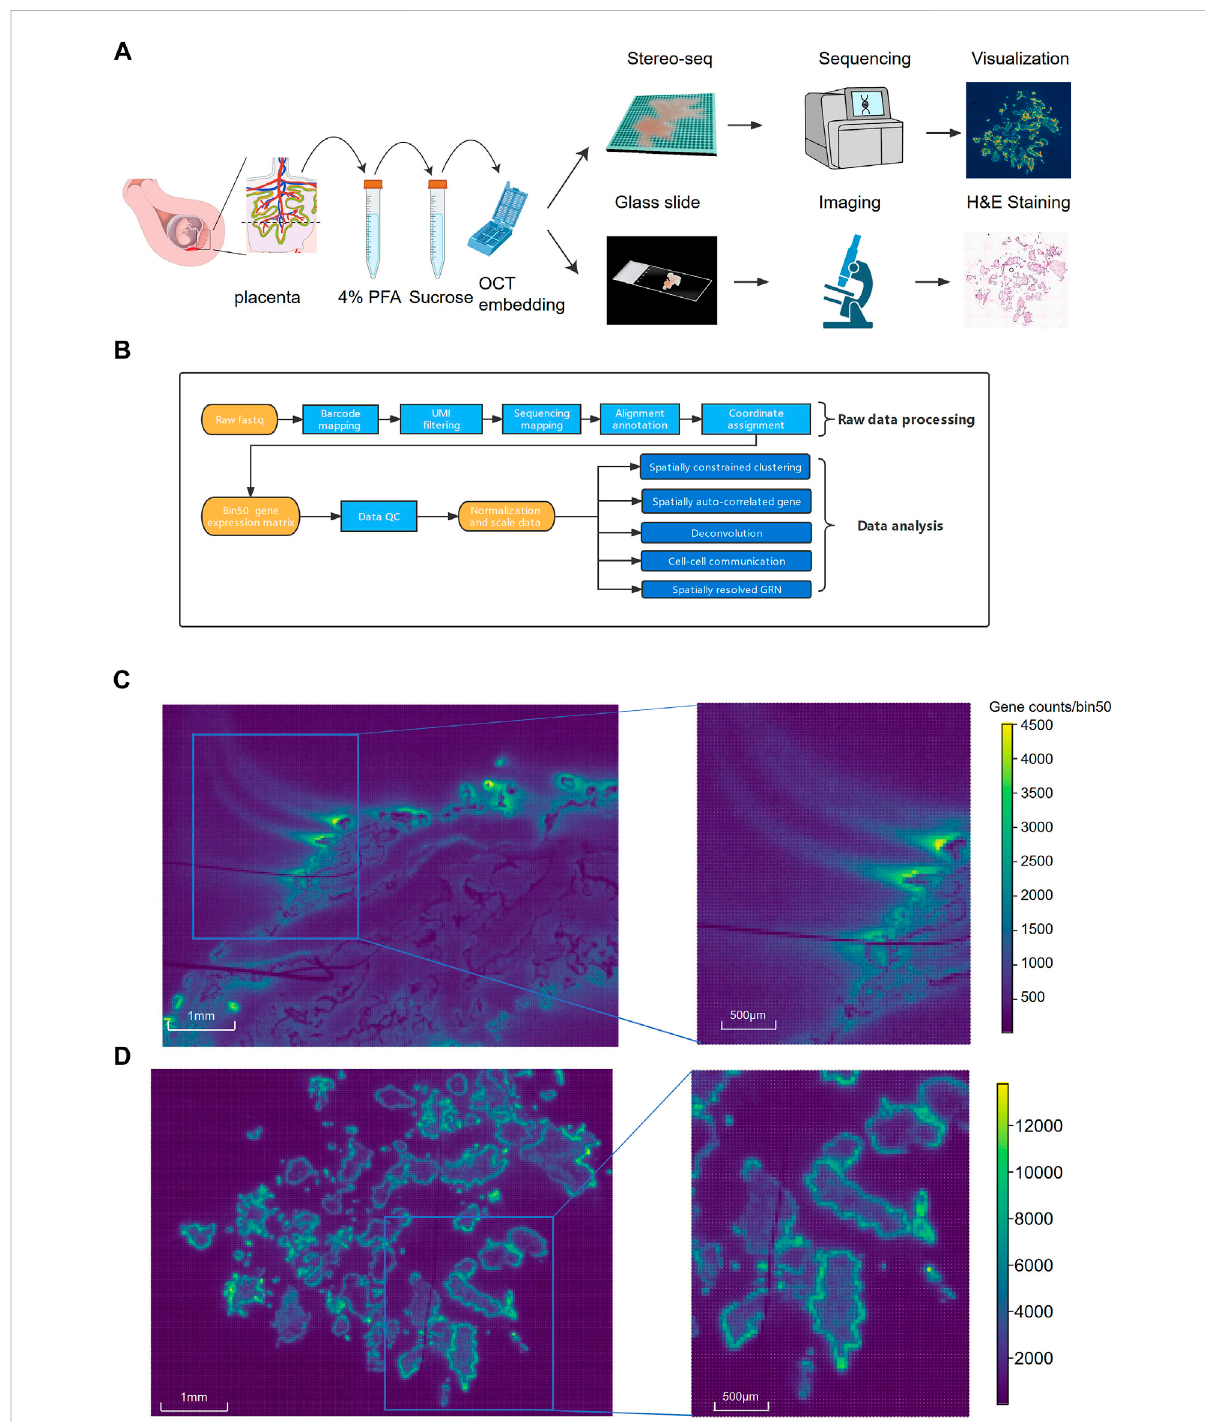
FIGURE 1 The schematic diagram of the experimental, data analysis work fl ow and comparison of Stereo-seq performance on fresh and PFA fi xed villi samples. (A) The work fl ow of Stereo-seq using the PFA- fi xed villi. (B) Pipeline of the data analysis. (C) The distribution of the signals on the chip from fresh villi sample. (D) The distribution of the signals on the chip from PFA- fi xed